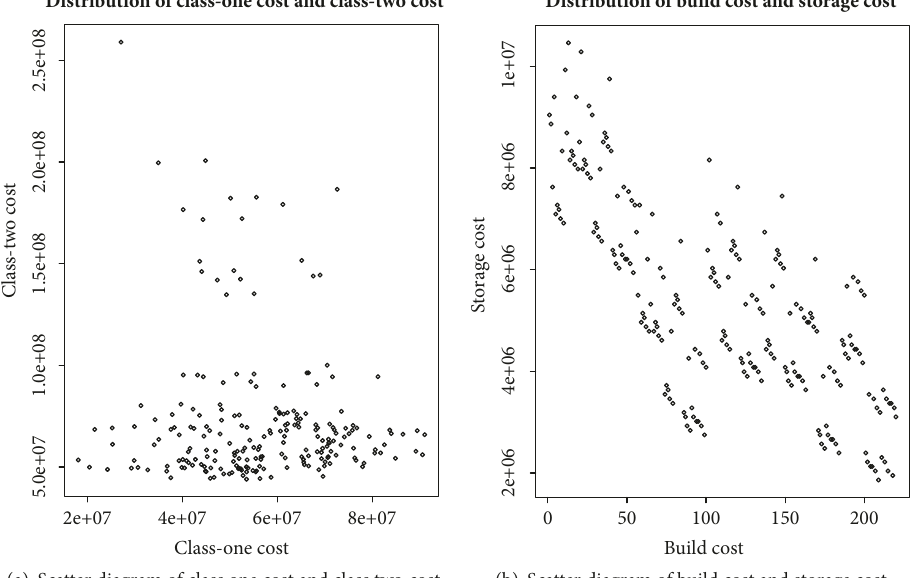
Figure 8: Scatter diagrams of costs, S1.